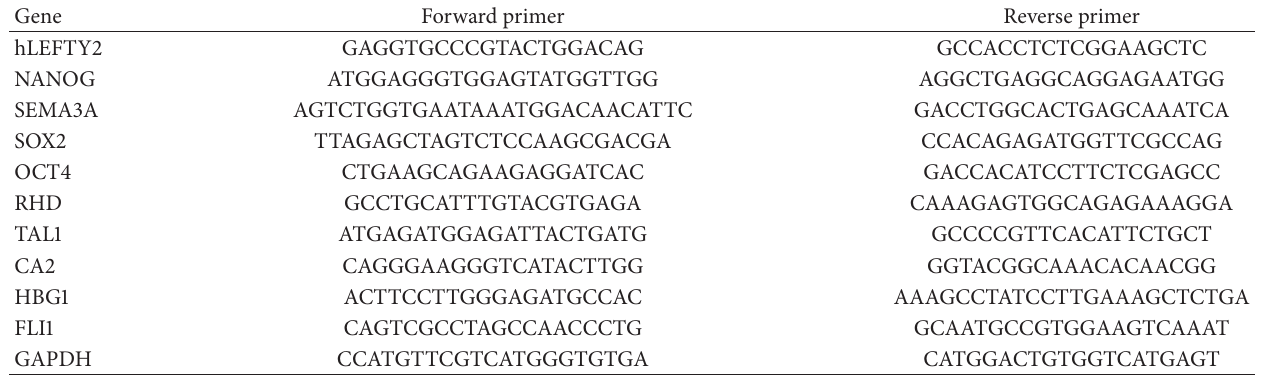
Table 1: qPCR primer sequences.